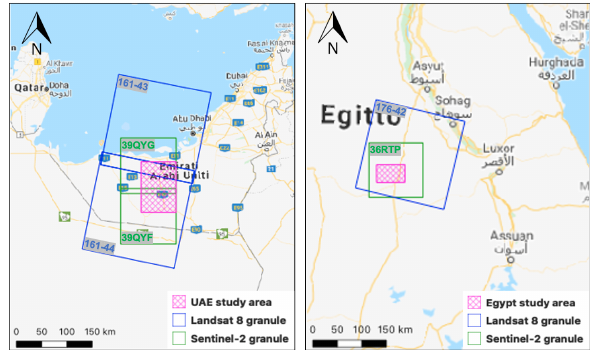
Figure 1. Study areas (pink pattern boxes) in UAE (right) and Egypt (left) with Landsat 8 (blue boxes) and Sentinel-2 granules coverage (green boxes). Map labels indicate the identifier of each considered granule (basemap: c (cid:13) 2020